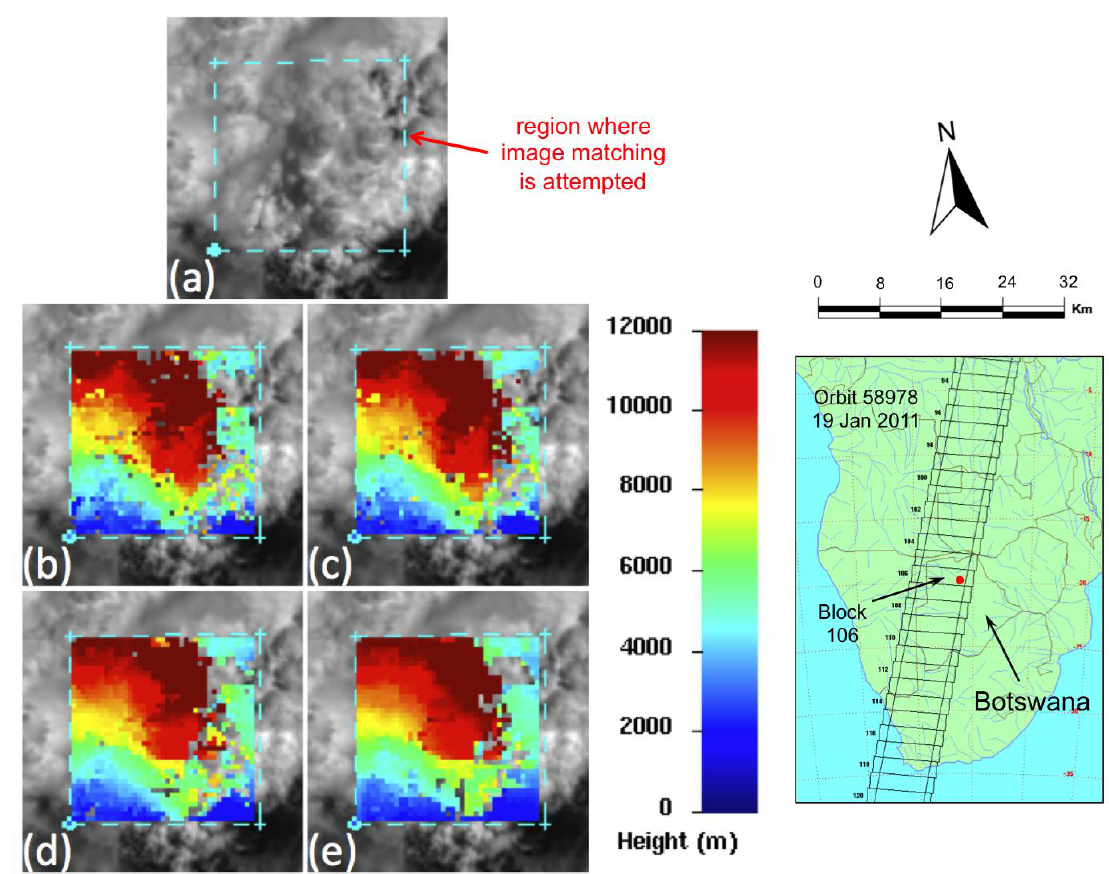
Figure 4. Zero-wind height retrievals over 2–12 km high clouds on orbit 58978, block 106, using different matcher template sizes to demonstrate their smoothing effect. The dashed aqua lines represent the digitized polygon inside which height retrievals are attempted. ( a ) Image of cloud field; ( b ) heights using 7 × 7 pixel template; ( c ) heights using 9 × 9 template; ( d ) heights using 13 × 13 template; and ( e ) heights using 23 × 23